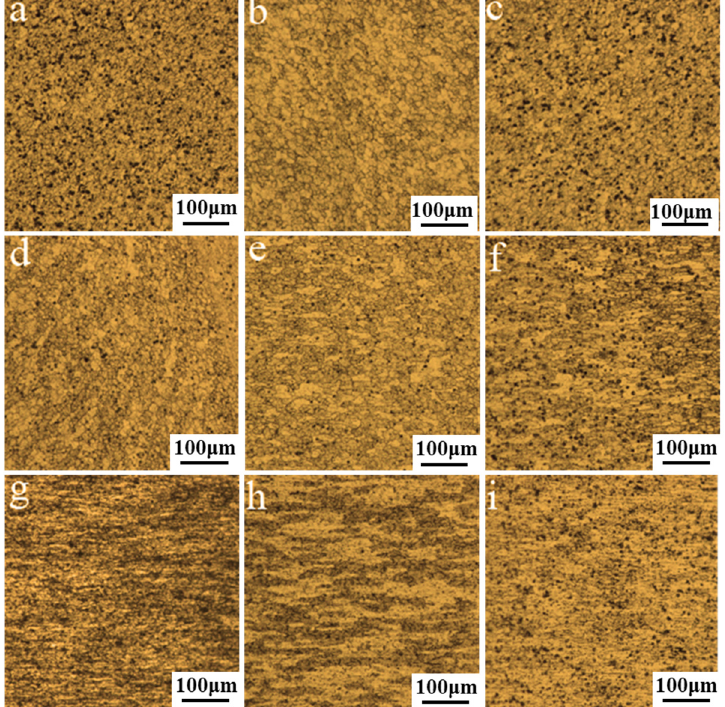
Figure 8. The microstructure of the joint in the section of: ( a ) NZ in the 150 mm/min joint; ( b ) NZ in the 250 mm/min joint; ( c ) NZ in the 450 mm/min joint; ( d ) TMAZ in the 150 mm/min joint; ( e ) TMAZ in the 250 mm/min joint; ( f ) TMAZ in the 450 mm/min joint; ( g ) HAZ in the 150 mm/min joint; ( h ) HAZ in the 250 mm/min joint and ( i ) HAZ in the 450 mm/min joint.